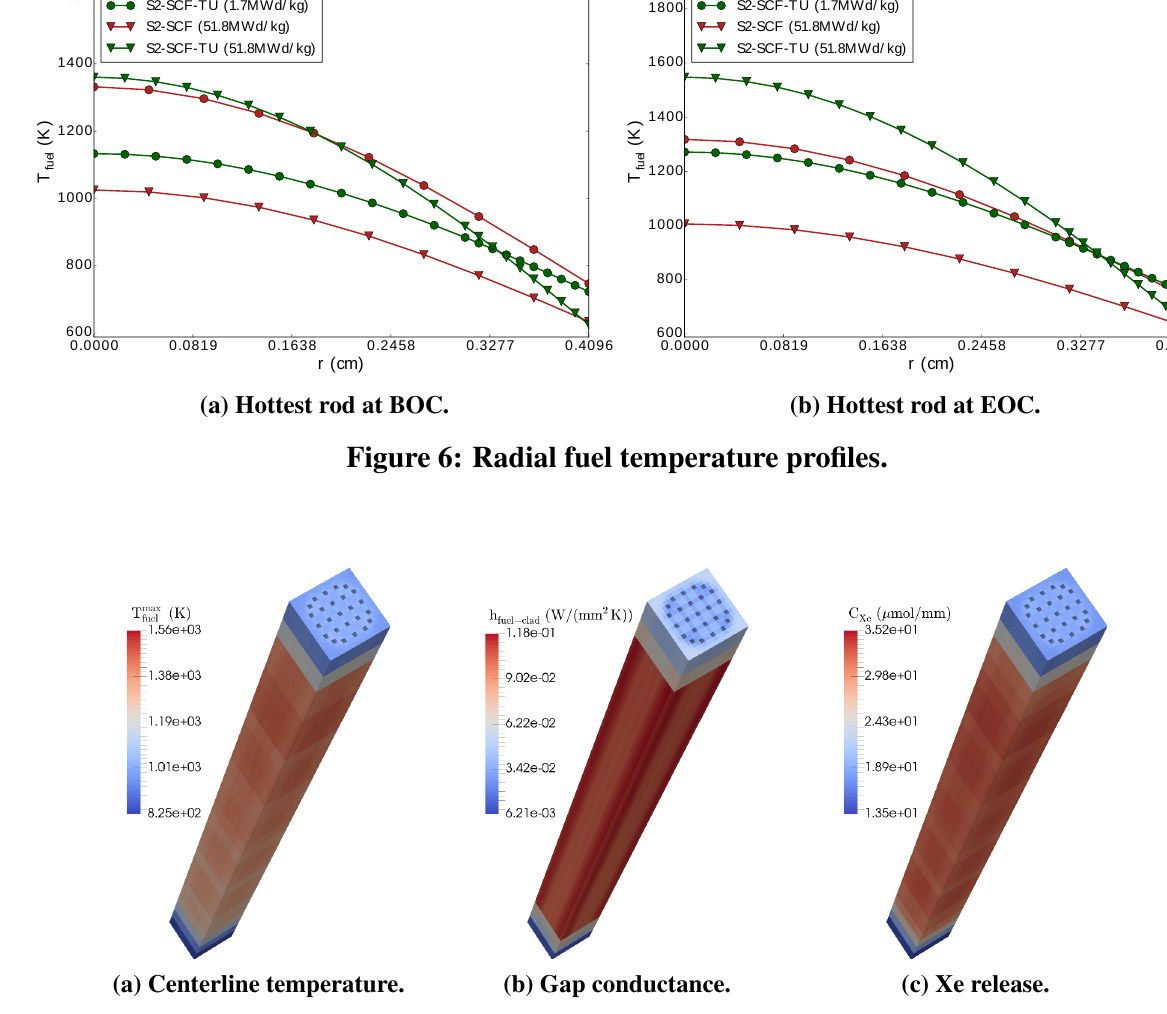
Figure 7: Serpent2-SCF-TU pin-by-pin results at